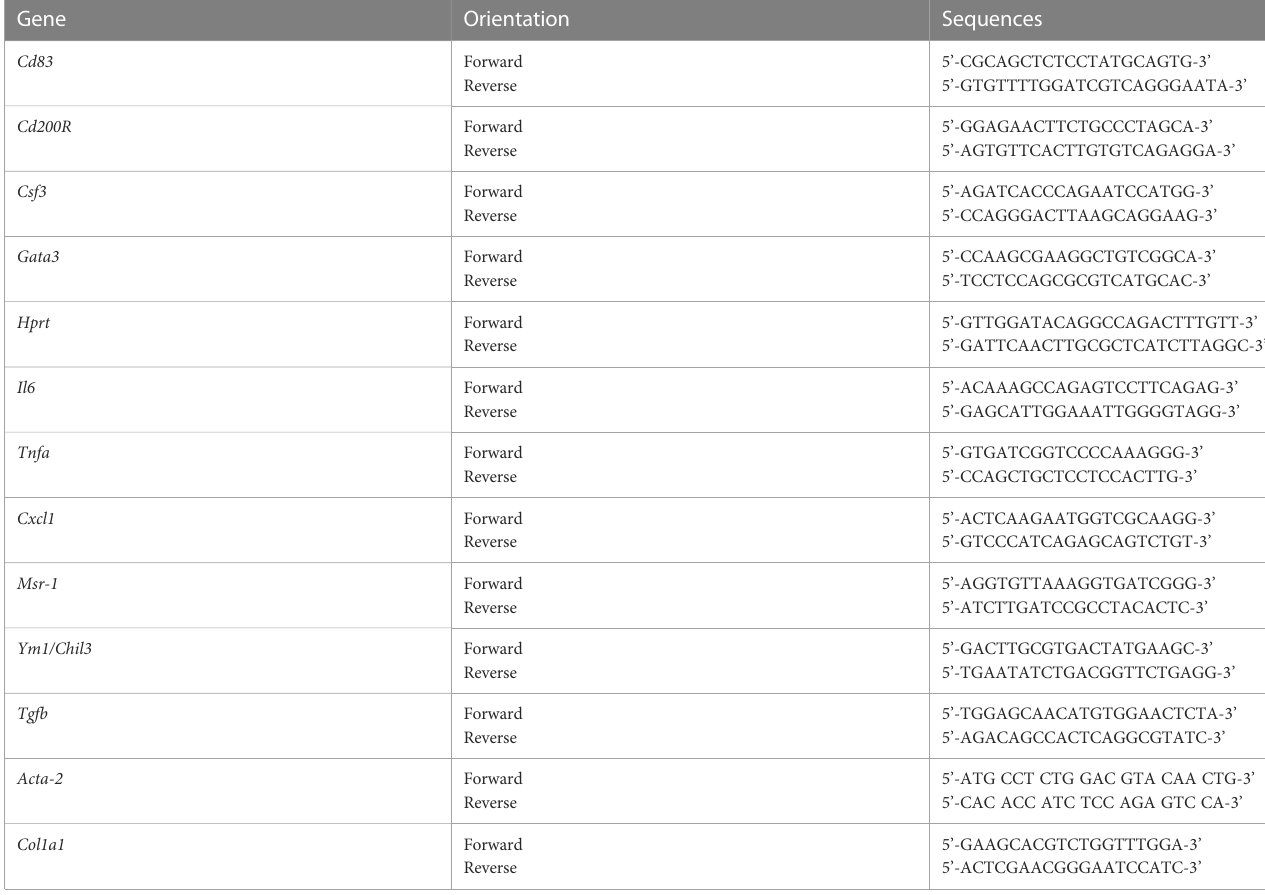
TABLE 1 Primer sequences used in qPCR experiments (Sigma